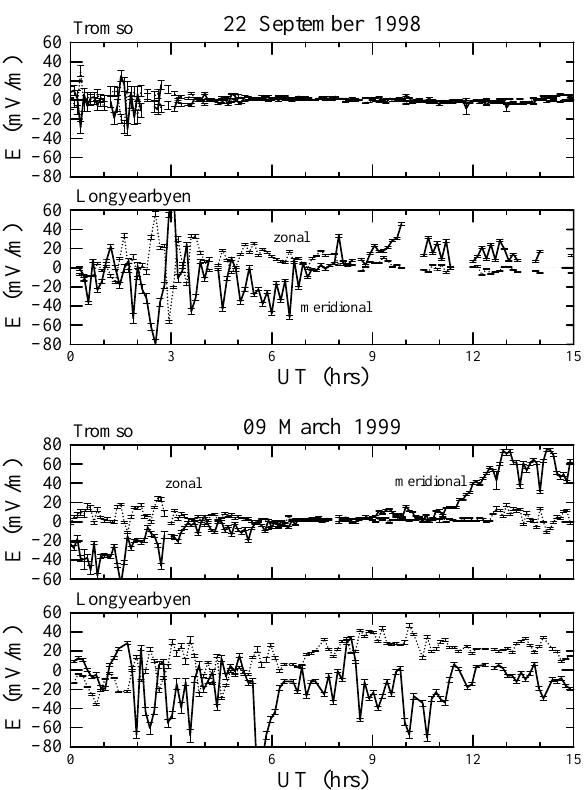
Fig. 3. Electric field strength measured by the EISCAT UHF radar at Tromsø (Tromsø radar) and the EISCAT Svalbard radar at Longyearbyen (Svalbard radar) between 00:00 and 15:00UT on 22 September 1998 and 9 March 1999. The solid line represents the meridional component and the dotted line the zonal component. The positive values indicate the northward and eastward compo- nents, respectively.